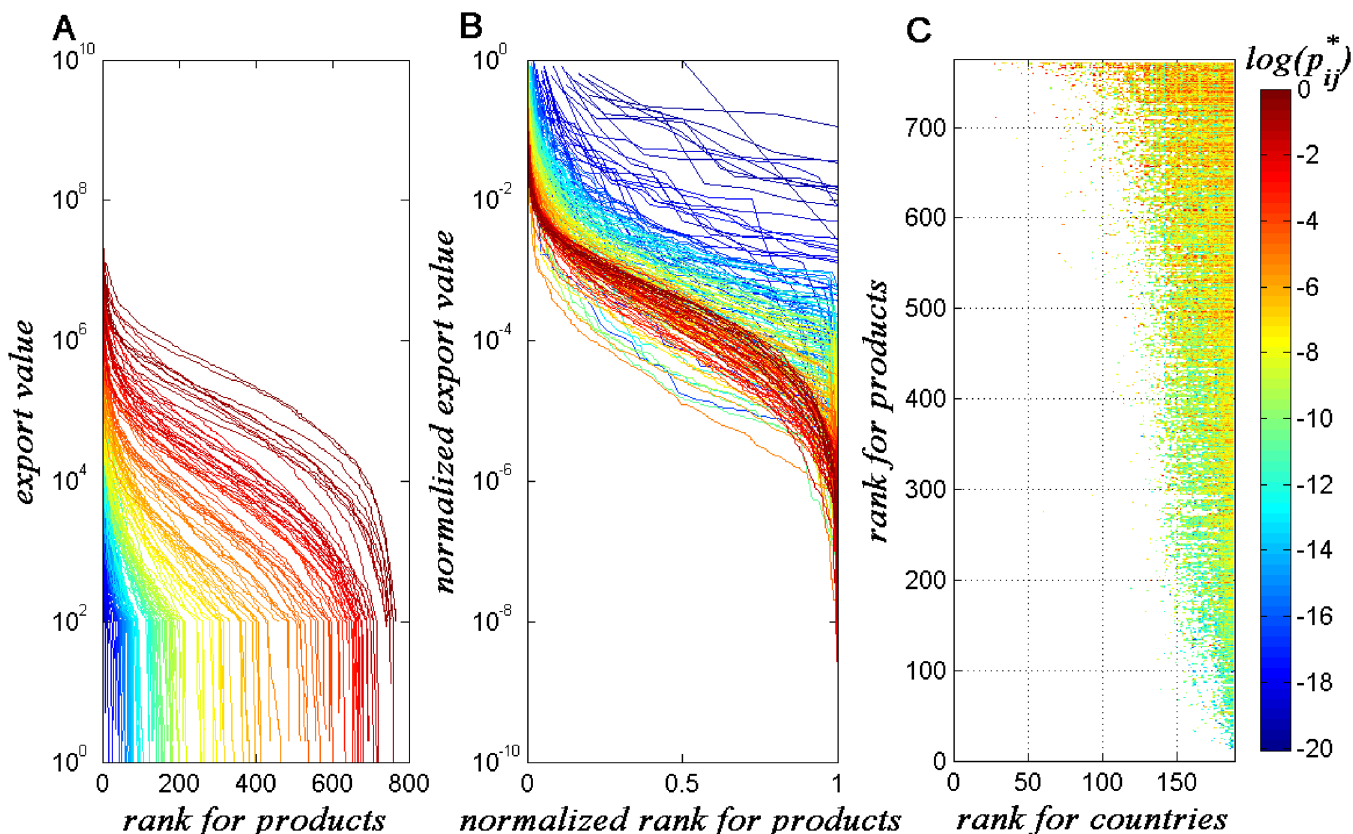
Fig 2. (A) Rank curves of the products trade values for all of the countries coloured by their ascending ranks. The rank curve for products is descending order of its export value in a specific country. (B) Normalized ranked export share curves for all countries coloured by the country ’ s total export values. (C) The matrix plot of the international division of labor from the empirical data. The horizontal axis represents the ranks of countries sorted by their total export values F i , and the vertical axis represents the ranks of products sorted by their ubiquity worldwide, which is at different scale from (A). The color in each entry represents the logarithmic trade shares p (cid:2) ij from i to j . This fi gure re fl ects the overall structure of the international division of